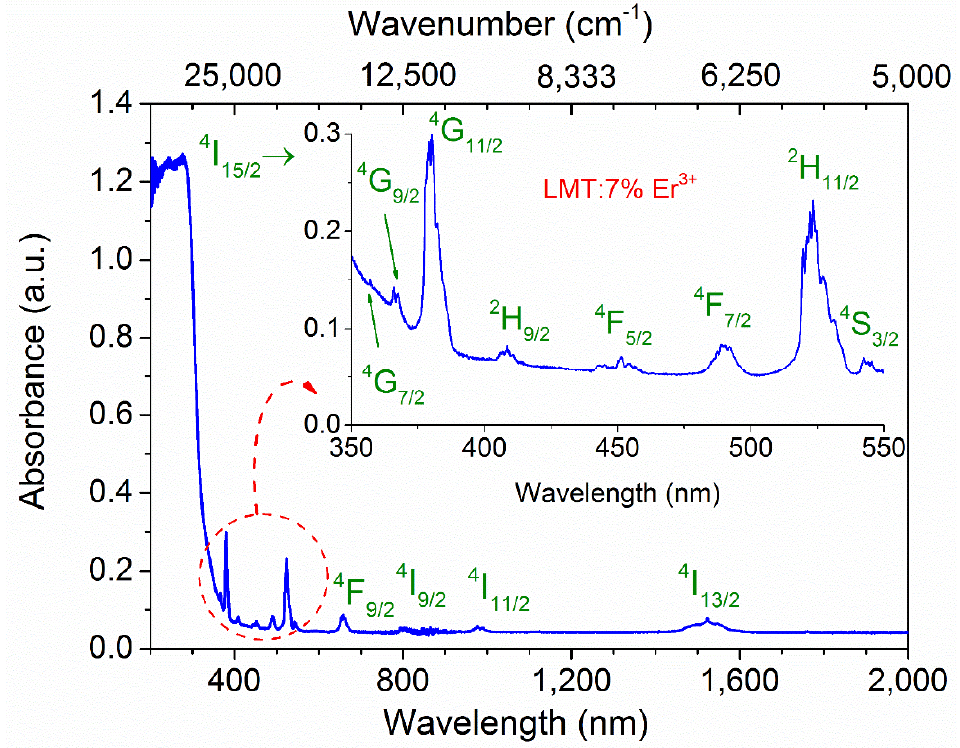
Figure 4. Absorption spectrum of La 2 MgTiO 6 :7% Er 3+ at room temperature. To determine the energy of the forbidden bandgap of the host and the sample doped with 7% Er 3+ , the modified Kubelka–Munk function (also known as the Tauc method) [34] was applied to the 300 K absorption spectra. The energy gap between the top of the valence band and the bottom of the conduction band of the host and LMT:7% Er 3+ were found to be 4.06 eV and 4.07 eV, respectively (Figure 5). The insignificant difference between them could have resulted from a measurement error. This value was slightly higher than that (3.98 eV) obtained for the same Pr 3+ -doped host [17].